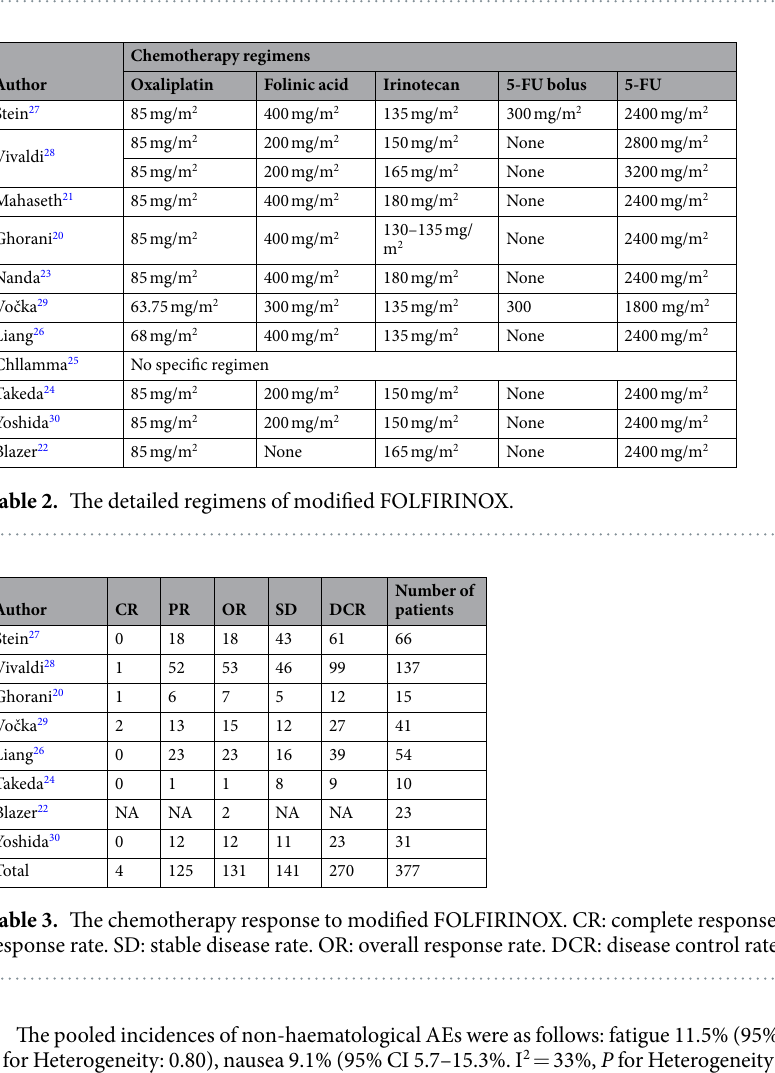
Table 1. Summary of the included studies. * There was an overlap in their study population. PS: ECOG performance status.